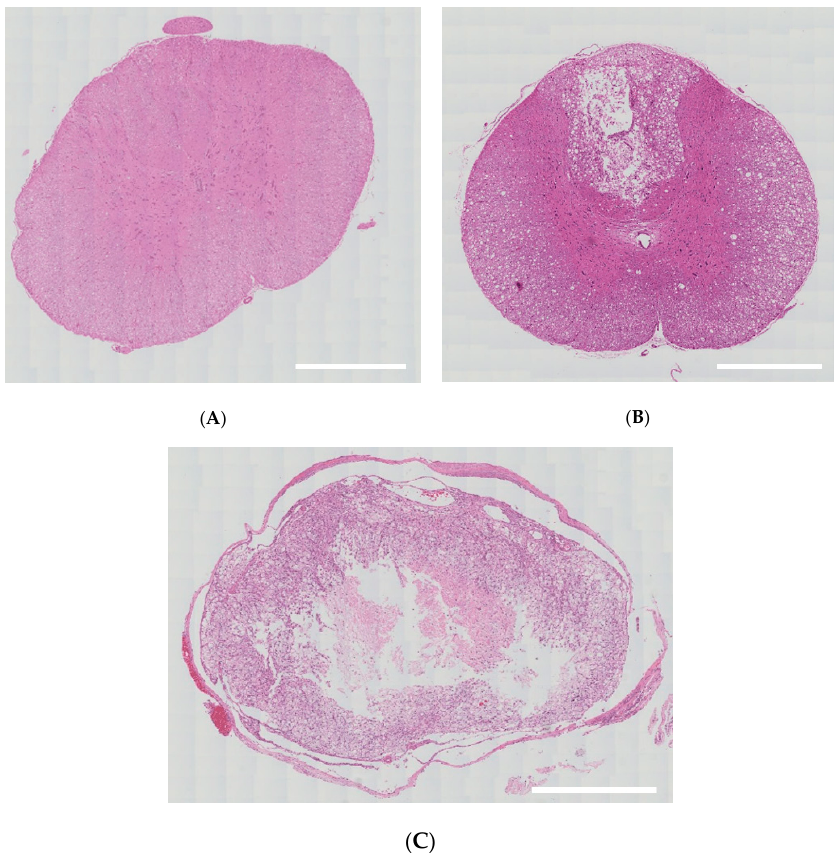
Figure 3. Histopathological findings. ( A ) There were no damages to the spinal cord in the sham group (36 × , H&E). ( B ) There were damages to only some part of the white and gray matter in the mild group (36 × , H&E). ( C ) Lesions of spinal cord were replaced by cavitation or fibrosis in the severe group (40 × , H&E). Scale bar indicates 500 μ m. 3.2. Alterations in the Level of miR-21 Expression according to the Time Course No differences in the level of miR-21 expression were found at the first time point studied (4 h post-lesion) between the three experimental groups, whereas such differences were significant at all the other time points ( P < 0.05) (Table 2; Figure 4).